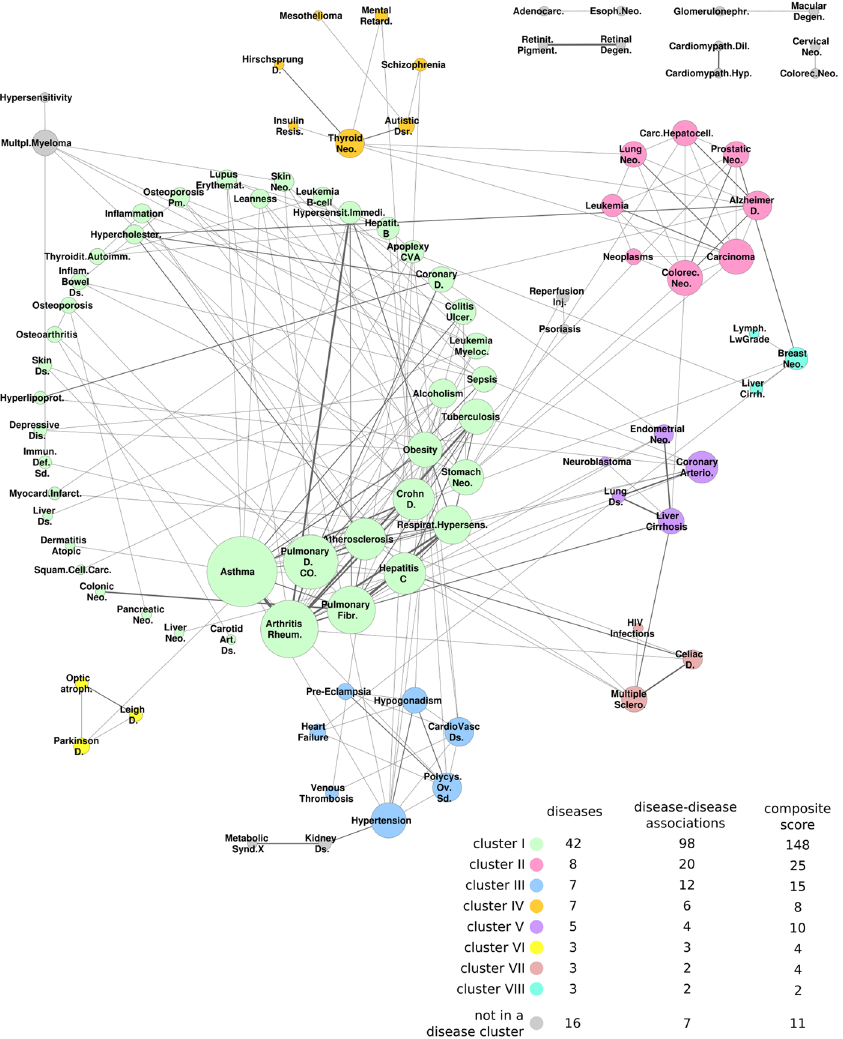
Figure 5. Disease-disease association (DDA) network. Disease network formed by 94 diseases (nodes) and 206 DDAs (edges) clustered using the MCL algorithm. Edge width is proportional to the composite score. Node size is proportional to its degree. Colour labels of clusters are shown at the bottom, along with the total number of diseases, the number of DDAs in the cluster and the sum of the composite score within the